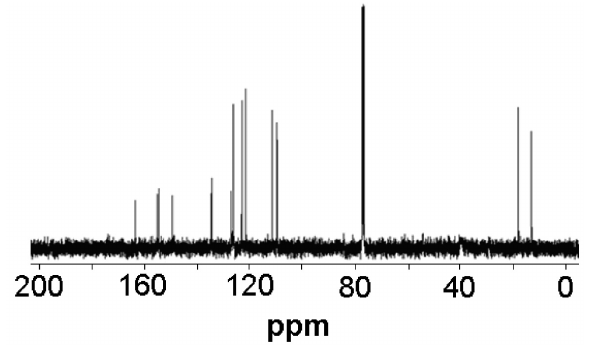
Fig. 3. 13 C-NMR spectrum of BMKMA monomer.